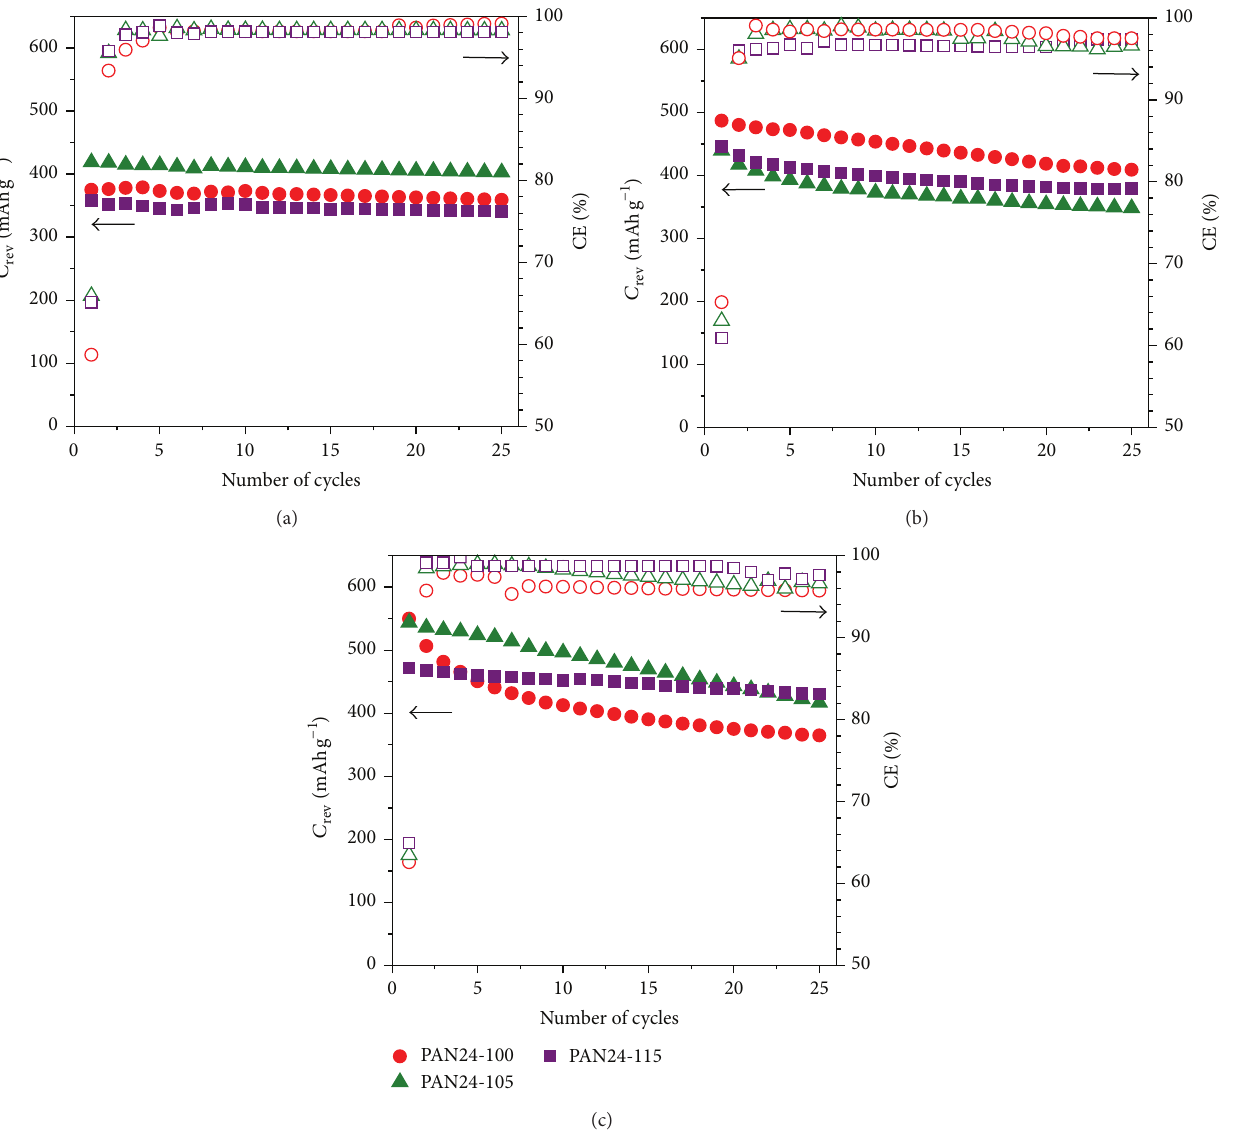
Figure 10: Cycleability of PAN-based (a), PAN22-based (b), and PAN24-based (c) carbons produced at different